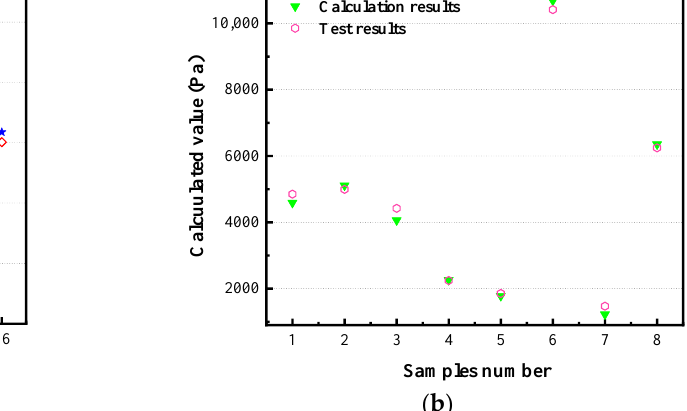
Figure 7. ( a ) Comparison of pressure loss simulation and calculation results; ( b ) comparison of pressure loss test and calculation results.